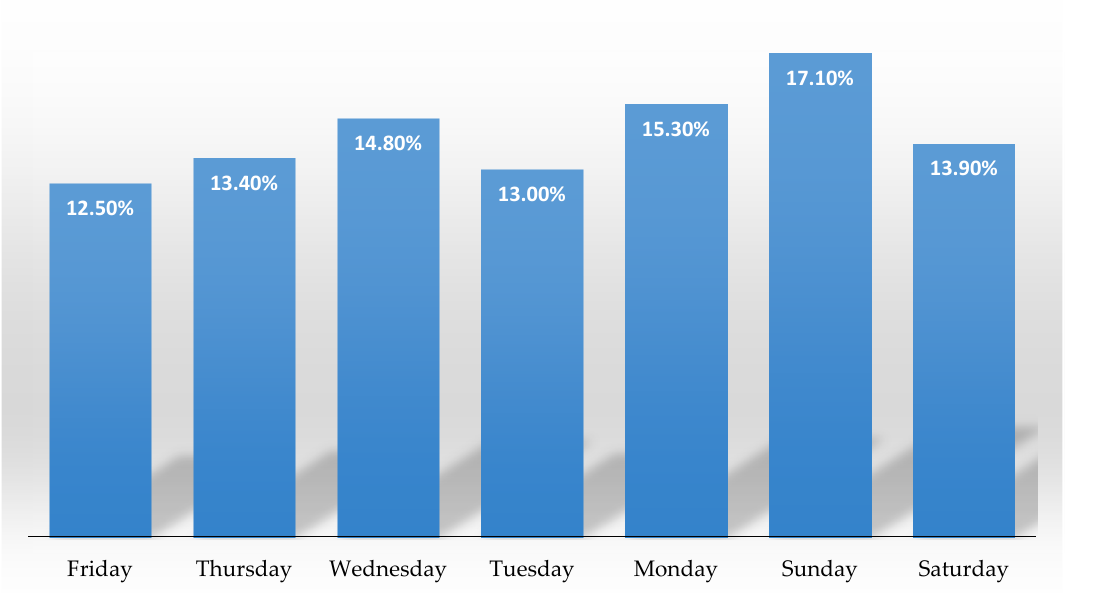
Figure 11. Cluster analysis for total daily demand at Madaba city depending on days of the week.